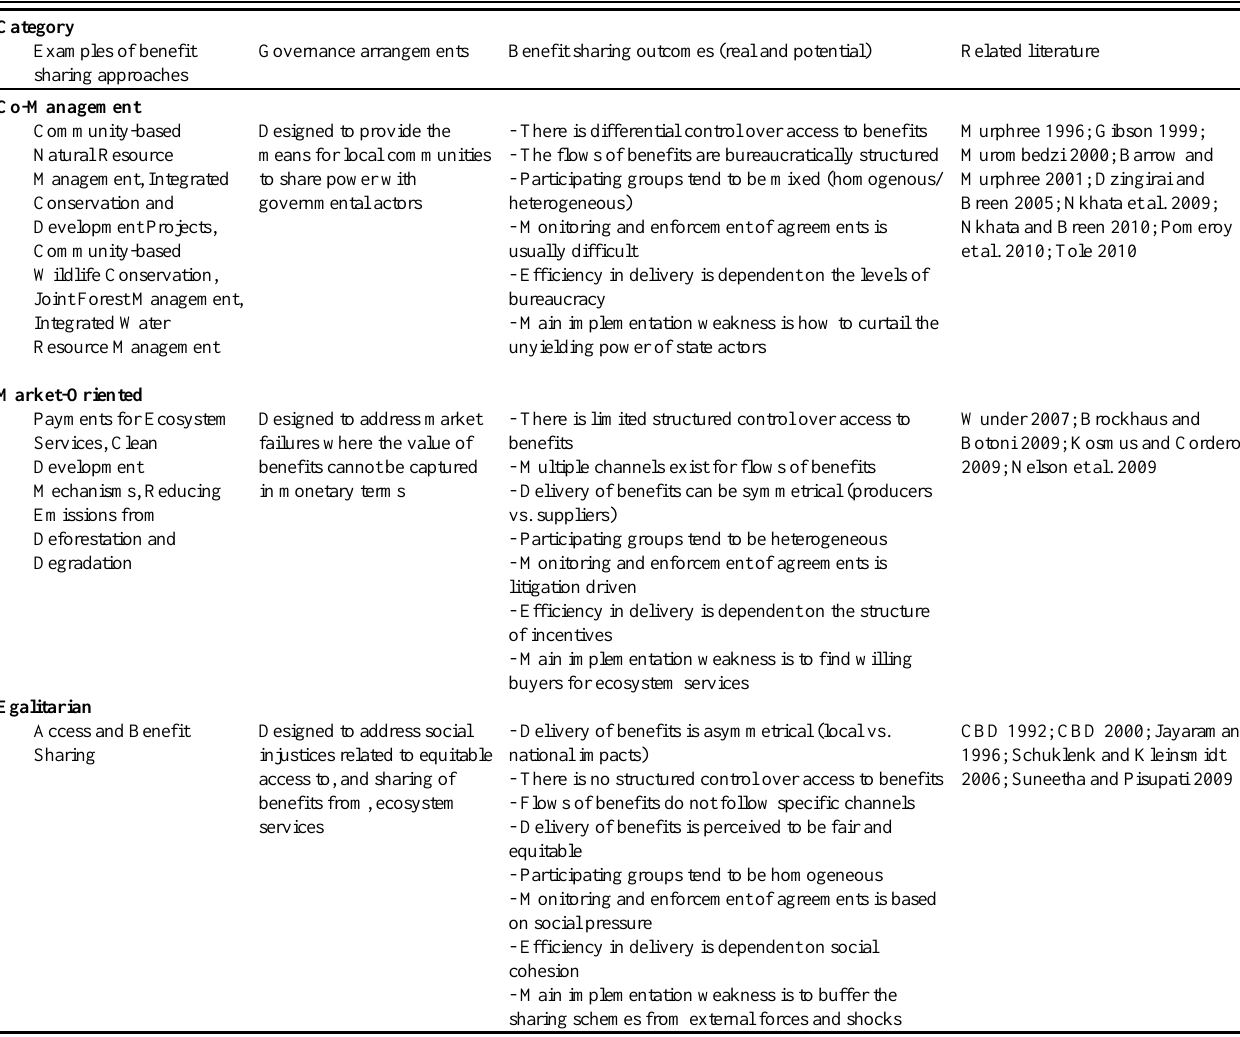
Table 1 . A proposed typology of benefit sharing arrangements for the governance of social-ecological systems in developing